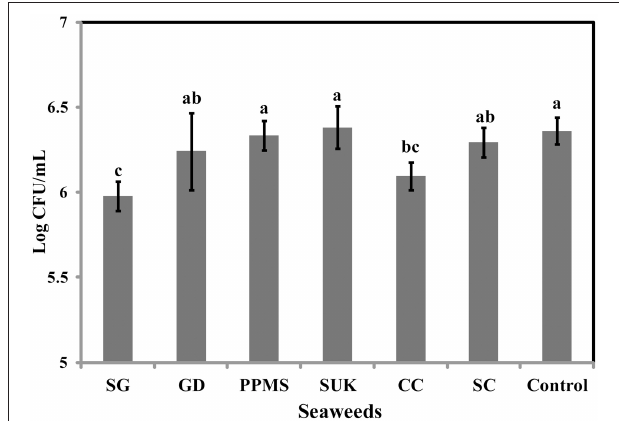
FIGURE 2 | Effect of red seaweeds on the growth of Salmonella Enteritidis growth. Six red seaweed species Chondrus crispus (CC), Gymnogongrus devoniensis (GD), Palmaria palmate (PPMS), Sarcodiotheca gaudichaudii (SG), Solieria chordalis (SC), and Sarcodiotheca spp (SUK) were tested against S. Enteritidis. A hundred µ l of fresh overnight culture was spread plated on the TSA plates containing ground seaweed (1% w/v).